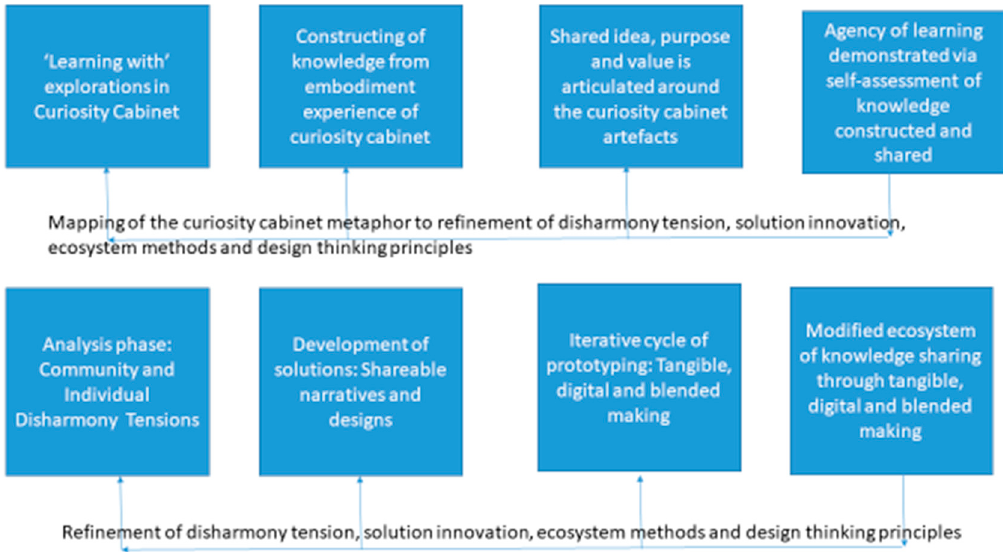
Figure 2. Mapping the curiosity cabinet metaphor to refinement of disharmony tensions, solution innovation, ecosystem methods, and design thinking principles.